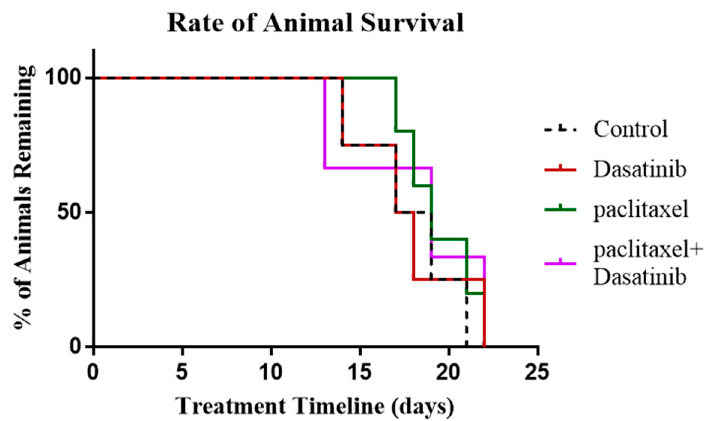
Figure 8. Survival analysis of paclitaxel, Dasatinib and combined paclitaxel and Dasatinib treated mice in recurrent phase. Kaplan-Meier survival analysis of control untreated mice (black dotted line), paclitaxel treated mice (green line), Dasatinib treated mice (red line) and paclitaxel and Dasatinib treated mice (purple line). Control mice were culled at the endpoint of experiment. The remaining groups of mice were monitored until they reached their individual endpoints.